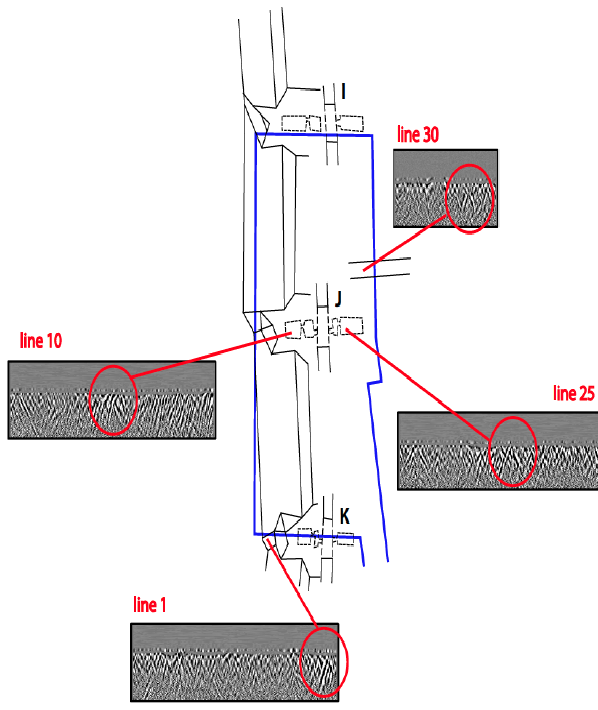
Figure 10. GPR signatures of putative historic structures, from the Phase-1 data acquisition.